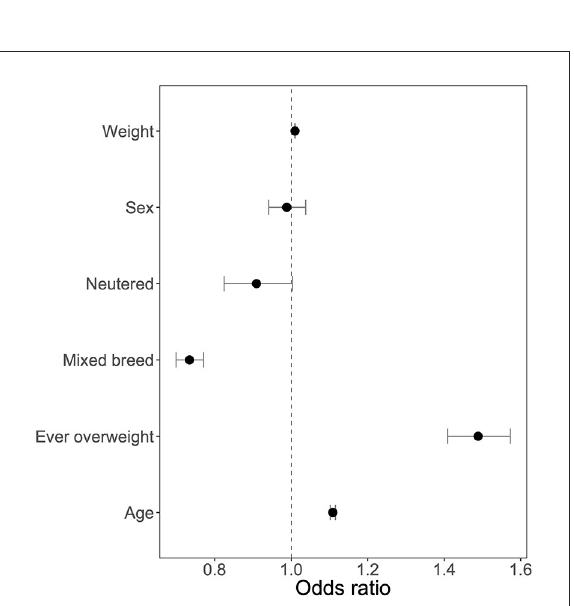
FIGURE2 Odds ratios of canine demographic factors with 95% Confidence Intervals. OR for weight indicates increase in joint supplement use for one pound increase in weight. OR for age indicates increase in joint supplement use for 1 year increase in